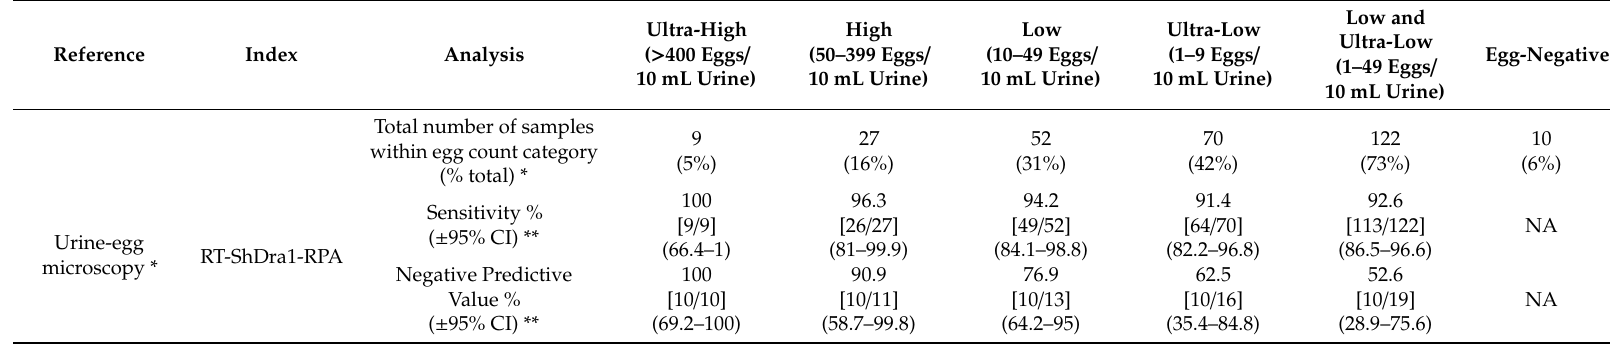
Table 2. All urine samples ( n = 168) categorised by degree of urine-egg output *. Sensitivity and negative predictive value analysis ( ± 95% CI) of the RT-ShDra1-RPA assay (index), compared to a urine-egg microscopy reference test across all egg count categories—ultra-high, high, low and ultra-low—are also outlined **. Low and ultra-low egg count categories were also amalgamated and analysed. Sensitivity and negative predictive value calculations are indicated within